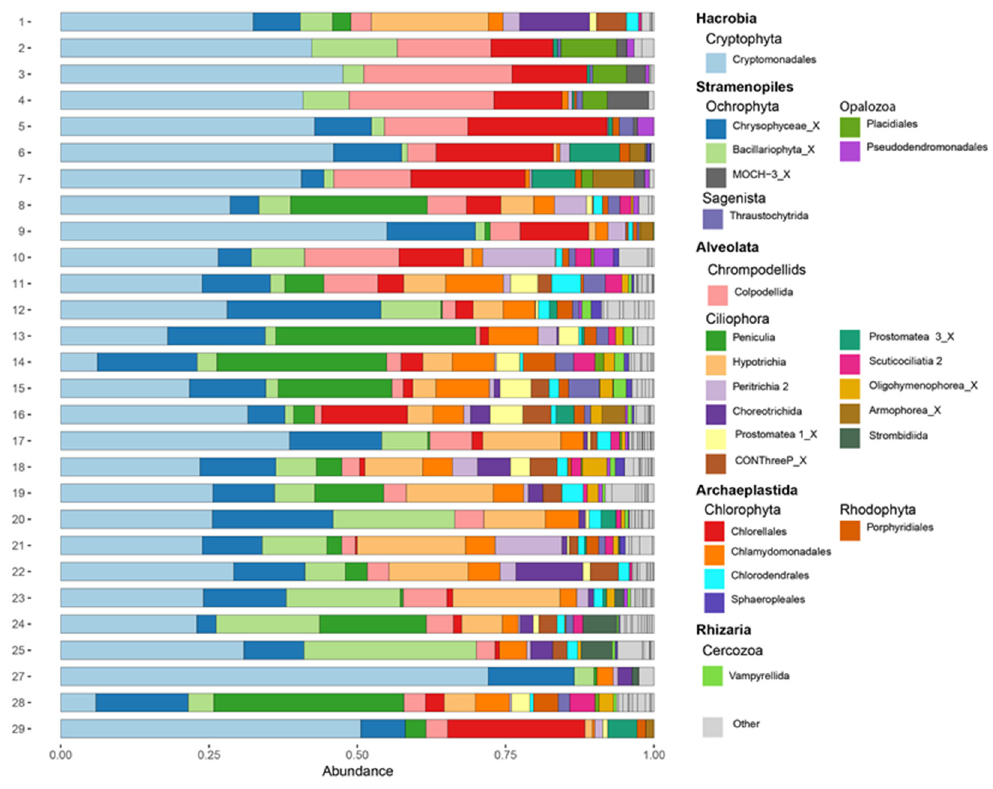
Figure 2. Relative abundance of protists, at the order level, within sampling sites, during 5–10 Oc- Figure tober 2019, along the New River, Belize. The 25 most abundant protistan groups are included.